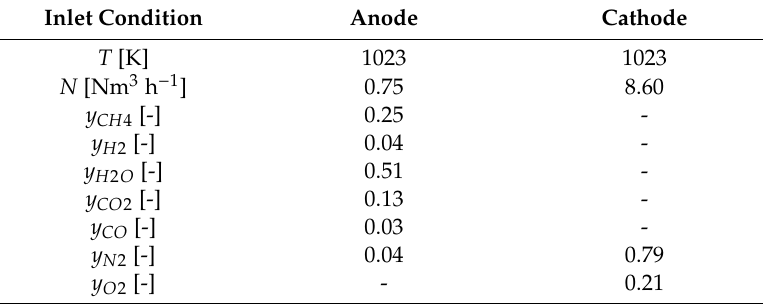
Table 4. Inlet operating